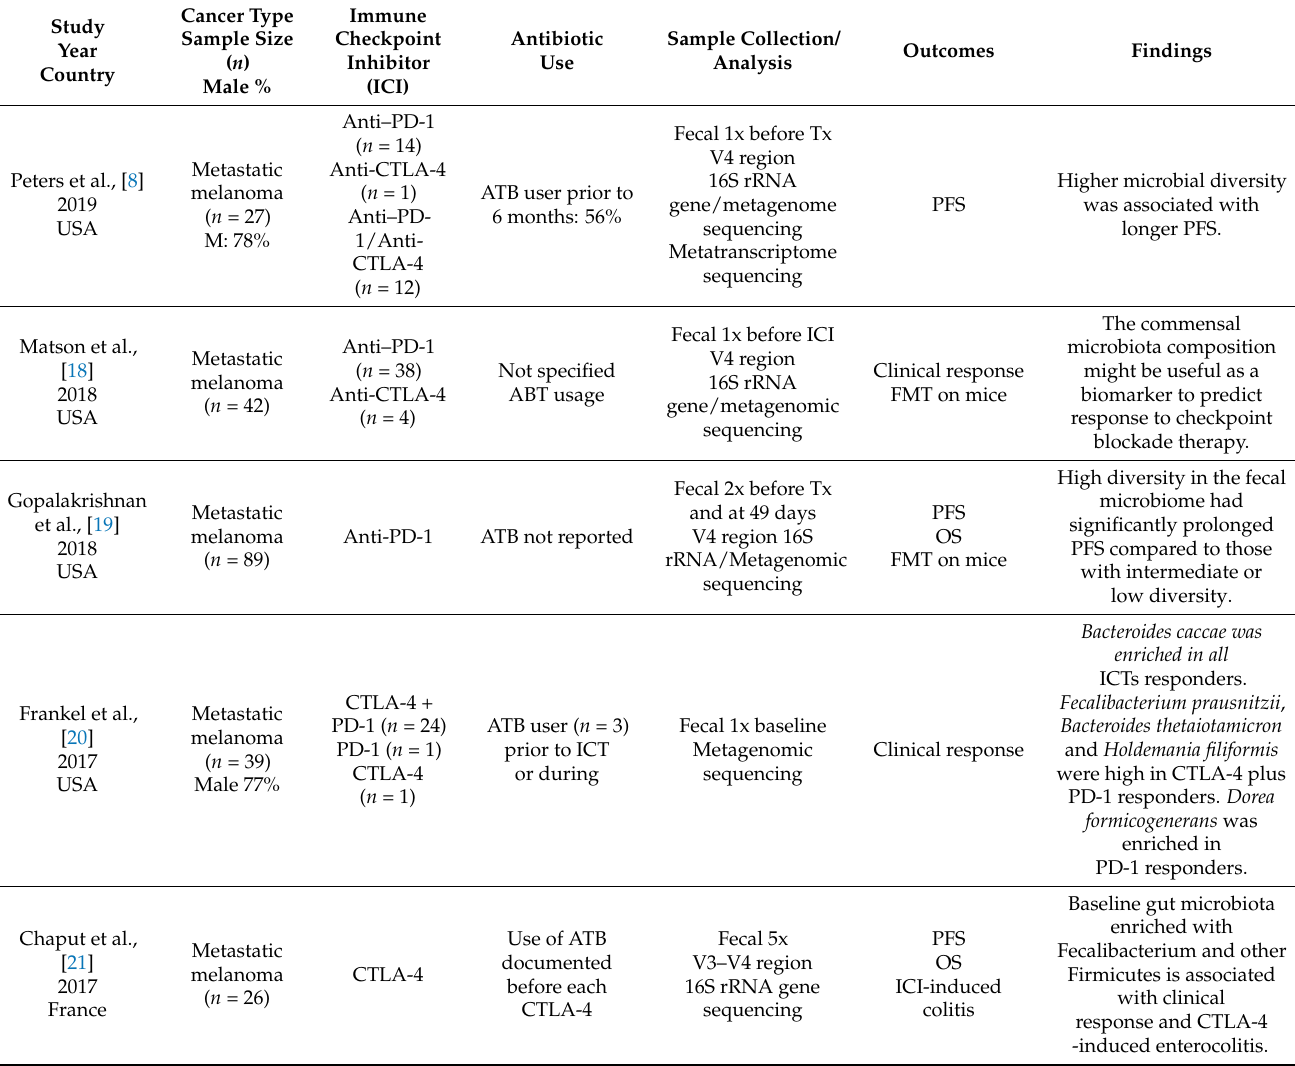
Table 1. Gut microbiota studies in